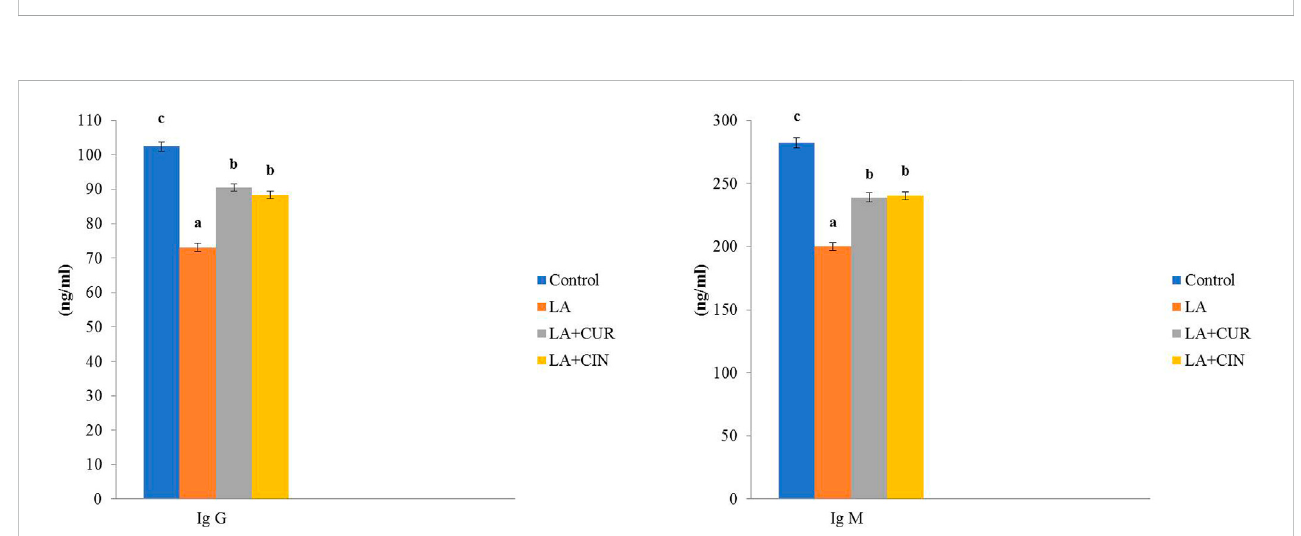
FIGURE 3 Changes of iron parameters in different treatment groups compared to the control (mean ± SE). Different superscript letters in each fi gure indicate signi fi cant differences at p < .05.